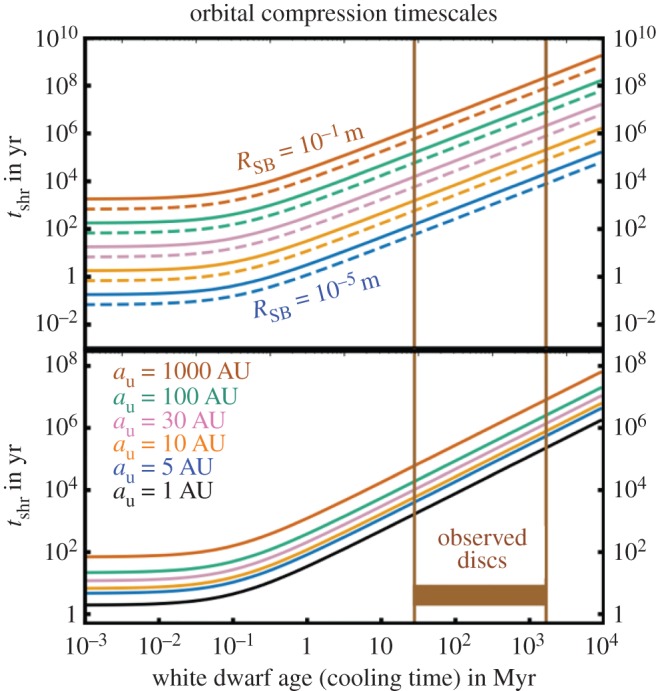
Cosmetically enhanced version of fig. 2 of [70]. How particles of given radii and semi-major axis shrink due to the effects of radiation alone, as a function of WD cooling time.